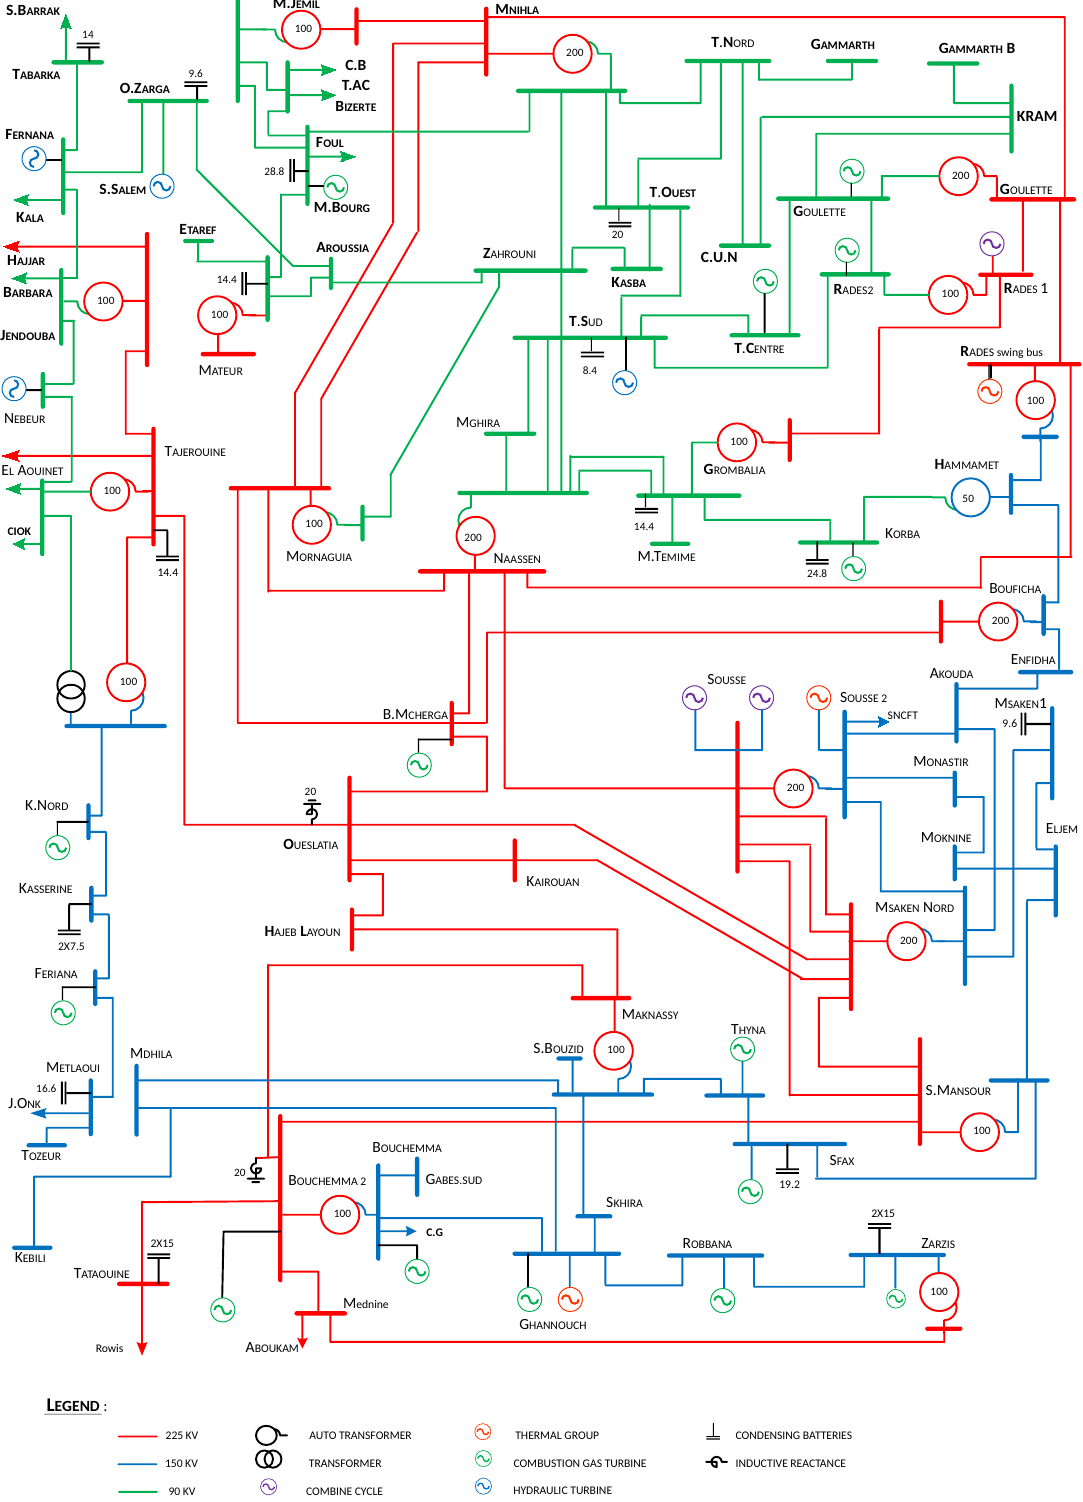
Figure 5. Tunisian 86-bus real power